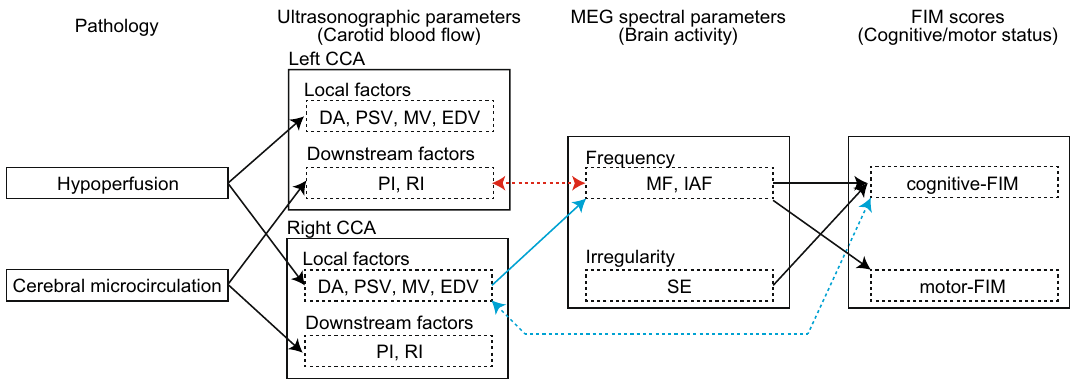
Figure 3. Relationships between ultrasonographic parameters, MEG spectral parameters, and FIM scores. A broken box represents subcategory of each modality. Broken arrows indicate the parameters’ significant correlations, whereas solid arrows indicate significant influences after controlling for biases in terms of patient age and sex. Red and blue arrows indicate significant associations regarding the left and right CCA, respectively (i.e ., asymmetrical association). Black arrows indicate significant associations not relevant to the asymmetricity of the CCA (left or right). CCA common carotid arteries, DA diameter of artery, EDV end-diastolic velocity, FIMFunctional Independence Measure, IAF individual alpha frequency, MEG magnetoencepharography, MF medianfrequency, MV mean velocity, P I pulsatility index, PSV peak systolic flow velocity, RI resistance index, SE Shannon